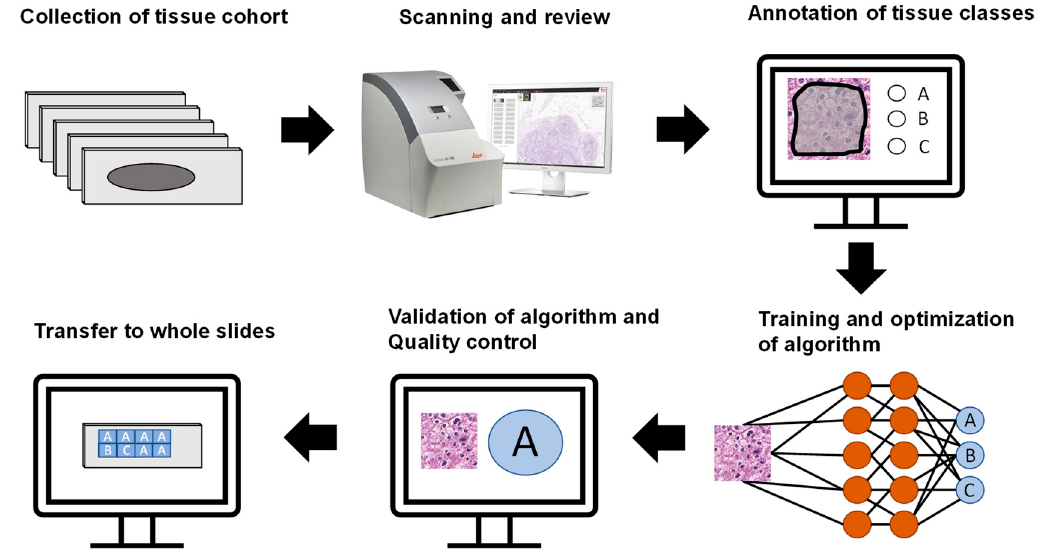
Figure 6. General workflow of the study. After collection of the tissue cohort, slides were scanned and reviewed. Tissue classes (A, B, C in this example) were annotated, and an algorithm was trained and optimized to classify these categories. The algorithm was validated, quality control was implemented, and the algorithm was applied to whole slides.